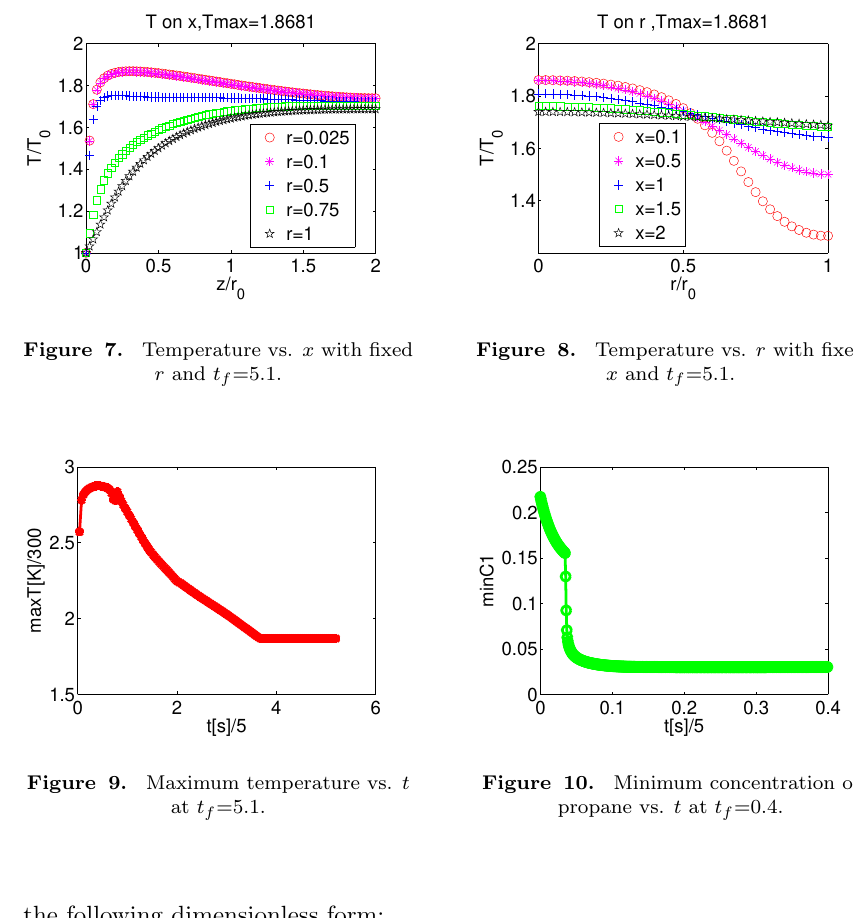
Figure 8. Temperature vs. r with fixed x and t f =5.1.